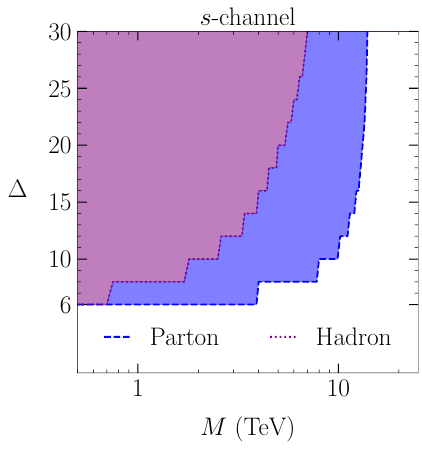
Figure 9 . The shaded region shows the parameter space in the plane of the EFT truncation dimension ∆ versus the BSM scale M with λ q = 2 , where the EFT is deemed invalid using the criterion in eq. (4.28) for the s -channel model. In the Partonic (Hadronic) Initial State case, we take √ √ s ) = 14 TeV. The inclusion of PDF effects opens up a region of potentially viable parameter ˆ s (